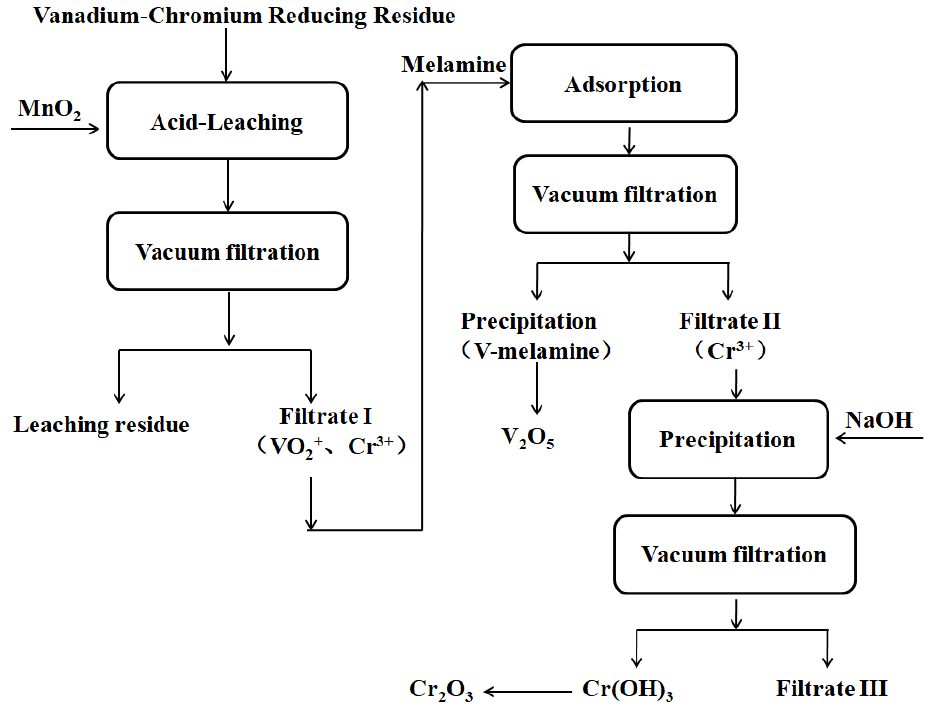
Figure 2. A flow sheet for the experimental procedure.